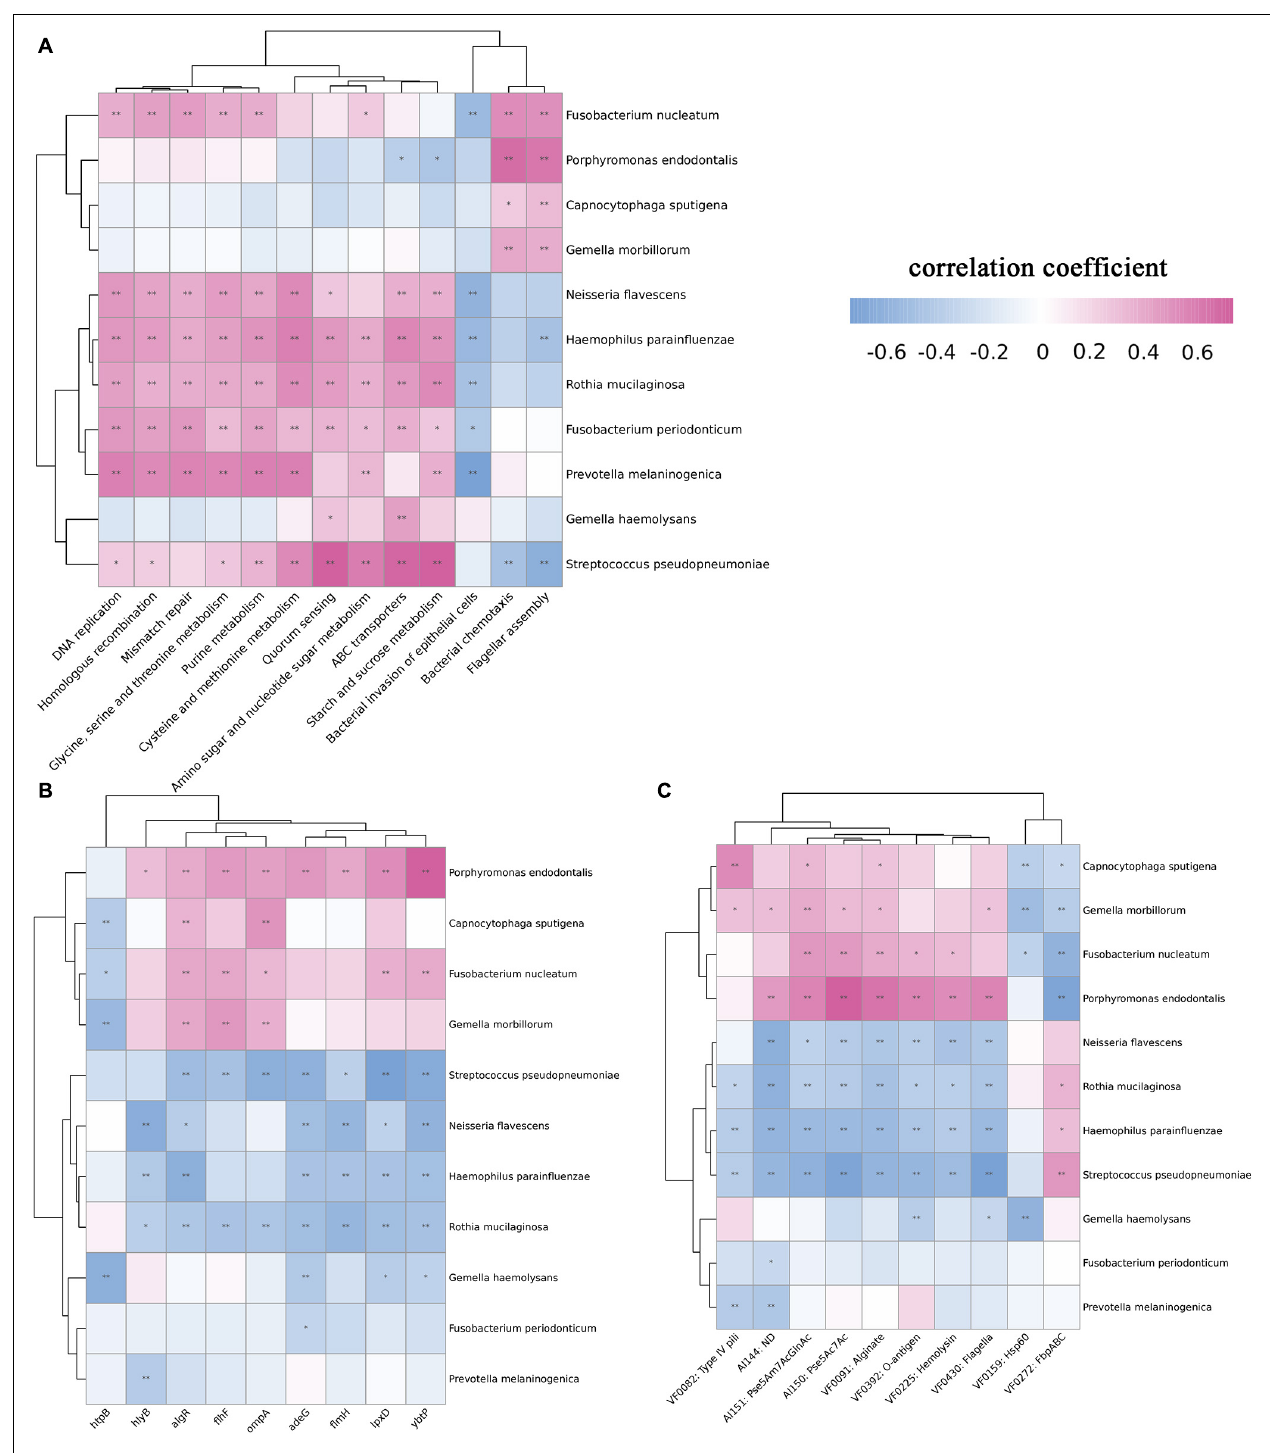
FIGURE 5 | Spearman correlation analysis between bacteria and function among the four groups. We selected bacteria that significantly increased or decreased during the progression of OSCC and analyzed the correlation between KEGG pathways, virulence genes, and virulence factors. (A) Correlation analysis between bacteria and KEGG pathways. F. nucleatum , C. sputigena , P. endodontalis , and G. haemolysans showed a significant positive correlation with bacterial chemotaxis and flagellar assembly. (B) Correlation analysis between bacteria and virulence genes. The pathogens F. nucleatum showed a significant positive correlation with the algR, flhF, ompA, lpxD, and ybtP genes. (C) Correlation analysis between bacteria and virulence factors. P. endodontalis and Pse5Ac7Ac, O-antigen showed a significant positive correlation with Pse5Ac7Ac and O-antigen. (using Kruskal-Wallis non-parametric tests,* p < 0.05, ** p < 0.01).